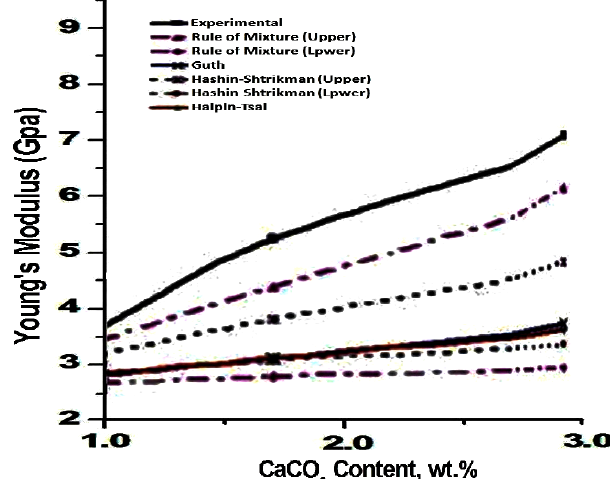
Fig. 15. Comparison of predicted Young’s modulus using theoreti- cal and experimental